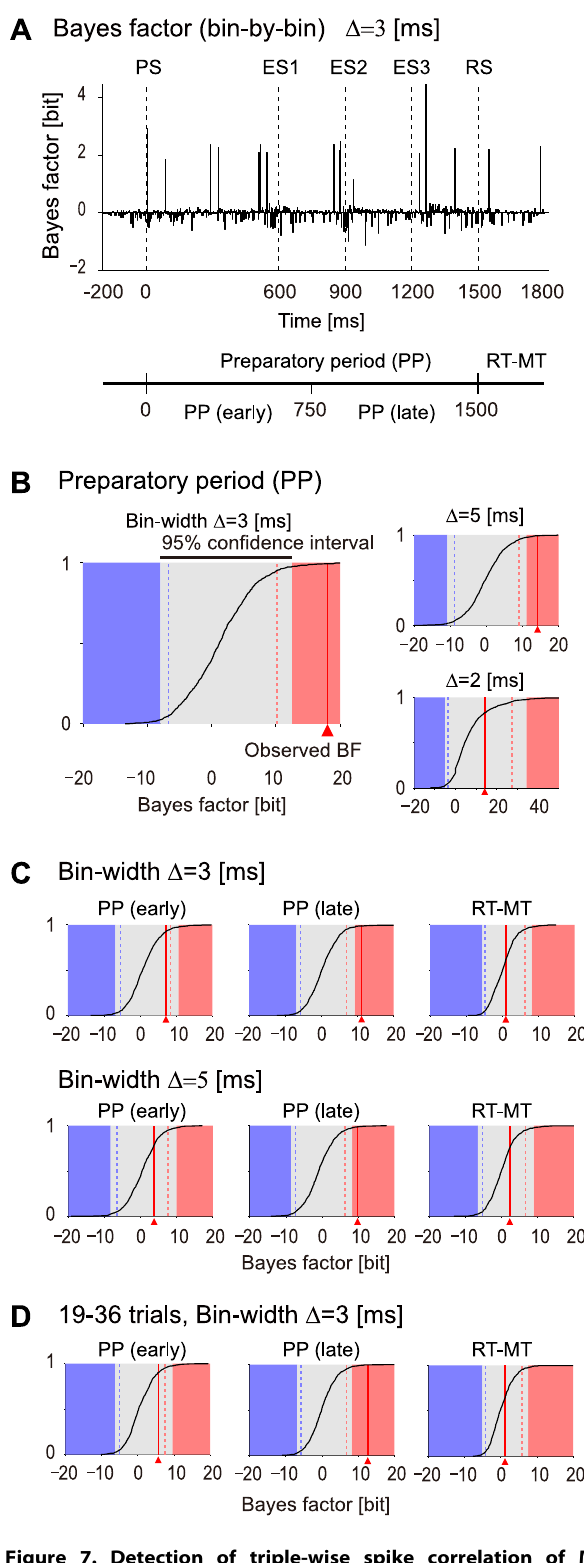
Figure 7. Detection of triple-wise spike correlation of MI neurons. (A) (Top) The bin-by-bin Bayes factor (BF) for a model of triple-wise spike interaction computed locally in time in bit units, Eq. 13. The bin-by-bin BF is computed from Eq. 13, using the state-space log- linear model fitted to the spike data (a total of 36 trials, 2 s binned using 3 ms bin-width; cf. Figure 6C). The BF computes evidence of a